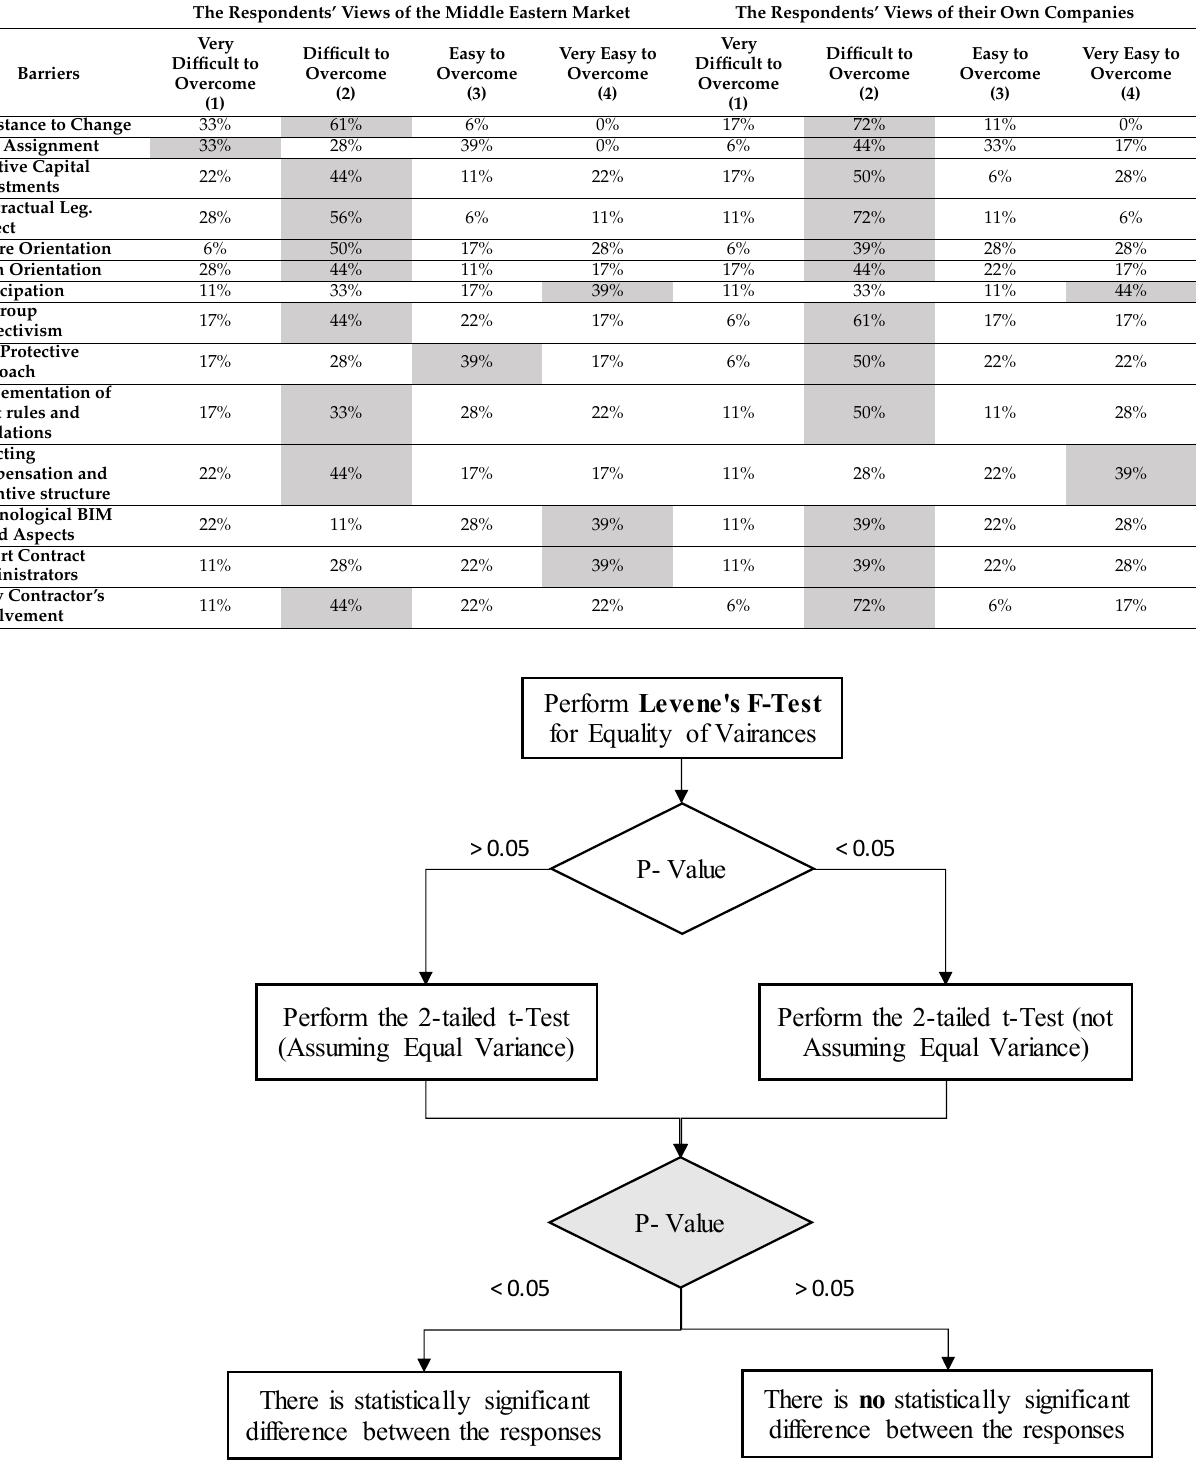
Figure 1. Procedure used to test and compare responses.